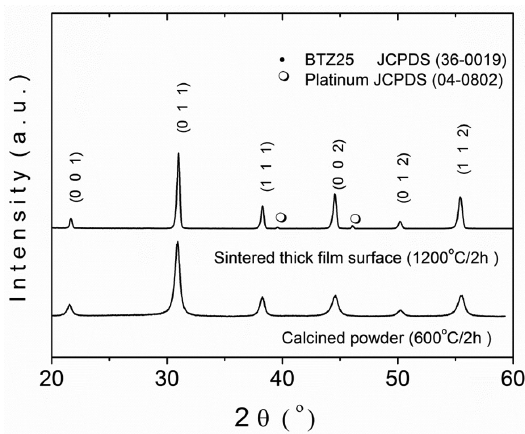
Figure 4. XRD patterns corresponding to (a) the BTZ powders (after calcination at 600 o C for 2h) and (b) the thick film surface (after sintered at 1200 °C/1h) (JCPDS 36-360019 BaTi The thick films was deposited with EtOH+Acac suspension, nanoparticles concentration of 5 mg/cm 3 , deposition time of 120s, electric field of 133 V/cm and sintered at 1220 °C/1h.